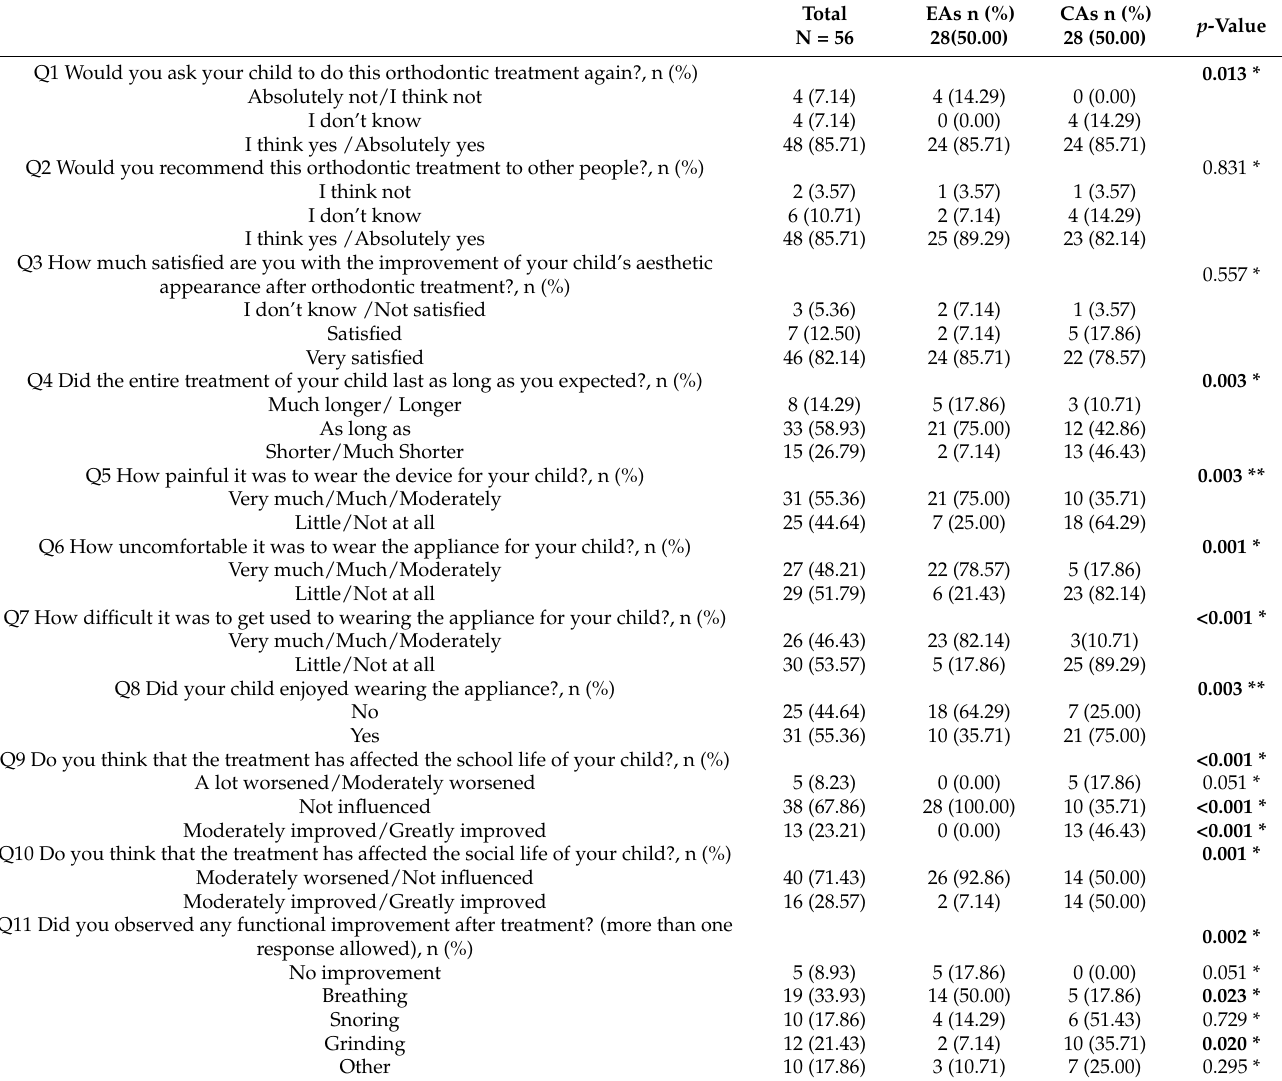
Table 2. Questionnaire’s items addressed to patients’ parents concerning general satisfaction with the orthodontic treatment, perception about the children’s satisfaction, and changes in function and lifestyle of children after treatment; EAs (Elastodontic Appliances), CAs (Clear Aligners).